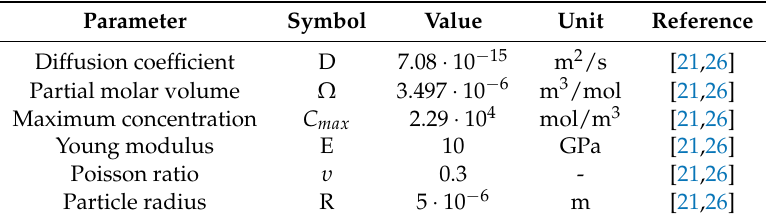
Table 2. Li x Mn 2 O 4 (LMO) properties